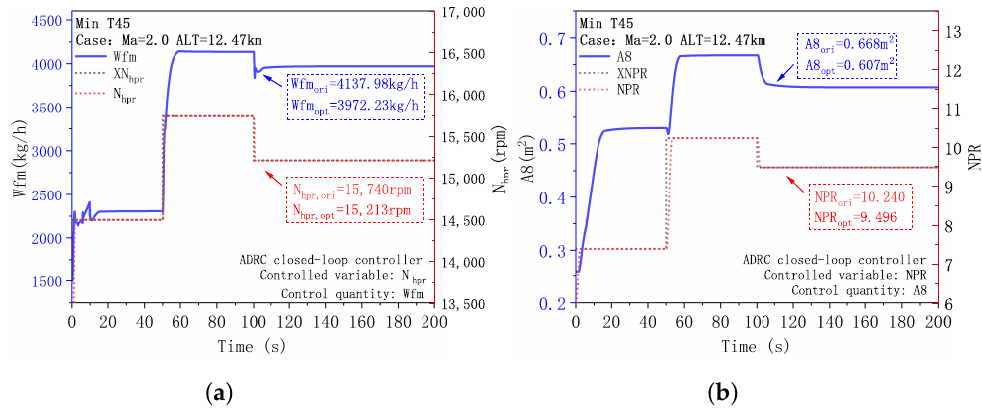
Figure 16. ( a ) Dynamic analysis of the controlled variables wfm and N hpr under Min T45 mode. ( b ) Dynamic analysis of the controlled variables A8 and NPR under Min T45